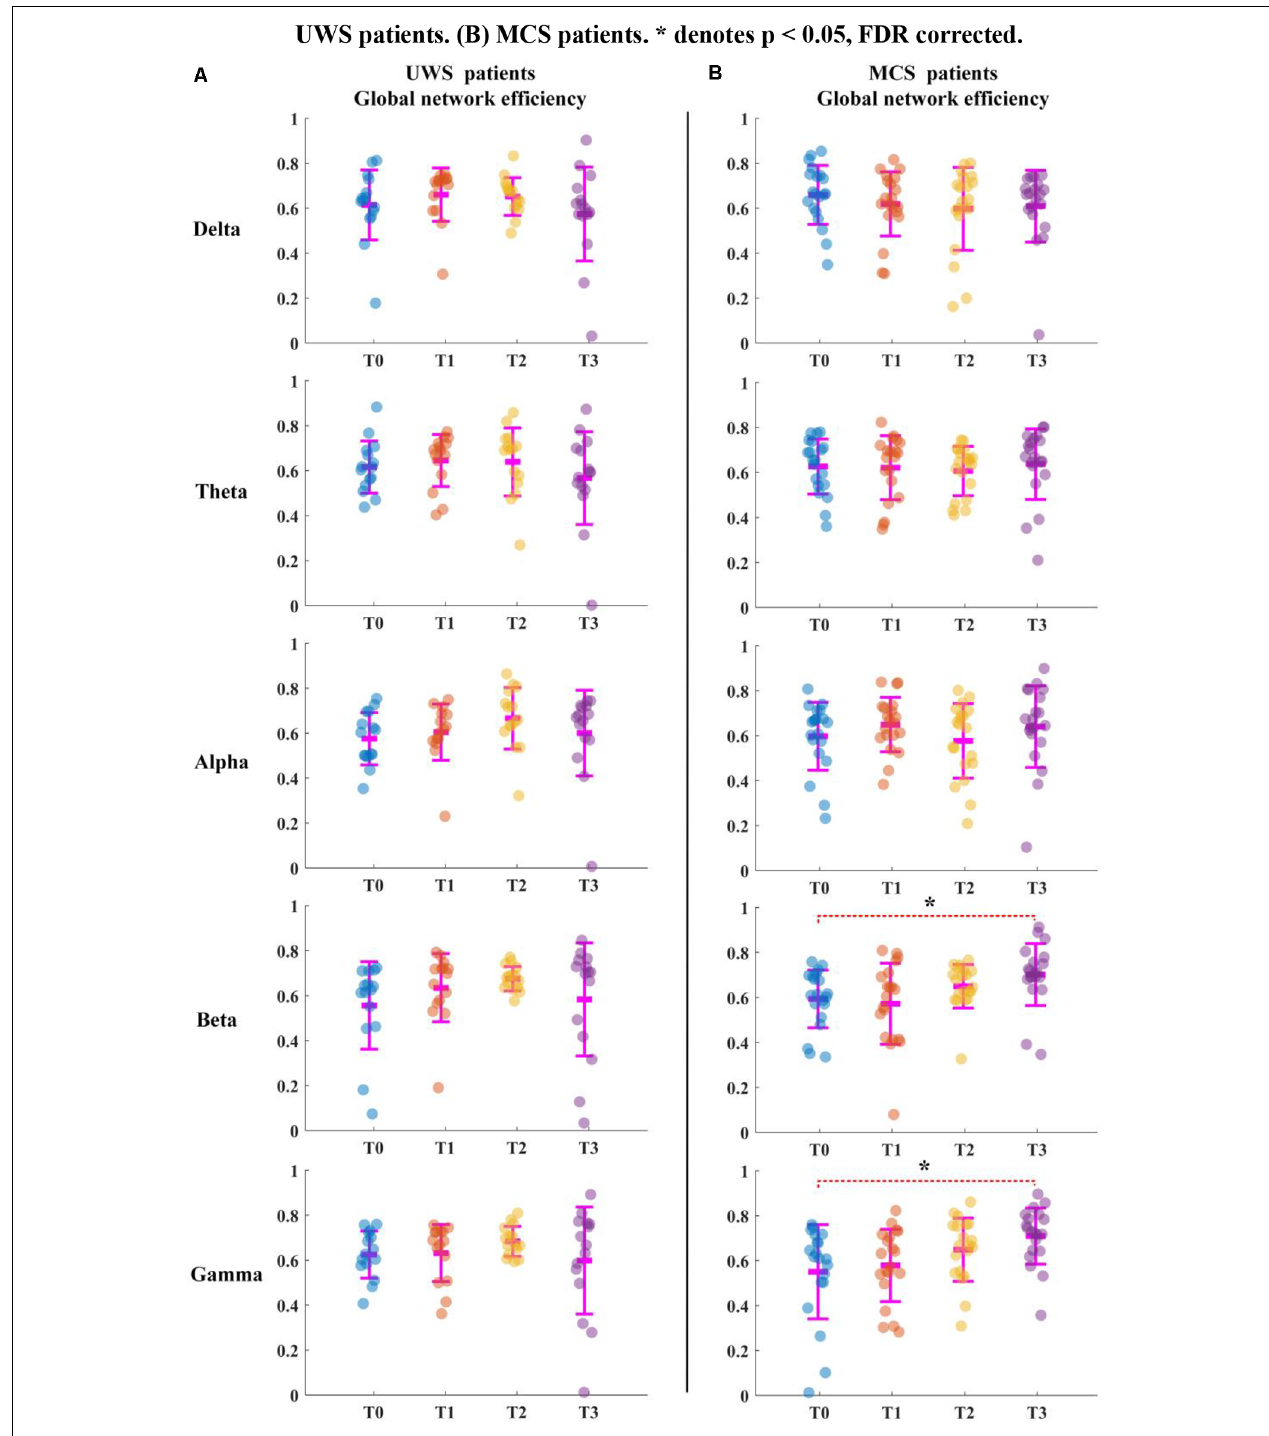
FIGURE 3 | Global network efficiency for all patients in five bands. T0, T1, T2, and T3 represent four EEG time points. The scatterplot shows the indicators of each patient. (A) UWS patients. (B) MCS patients. *Denotes p < 0.05, FDR